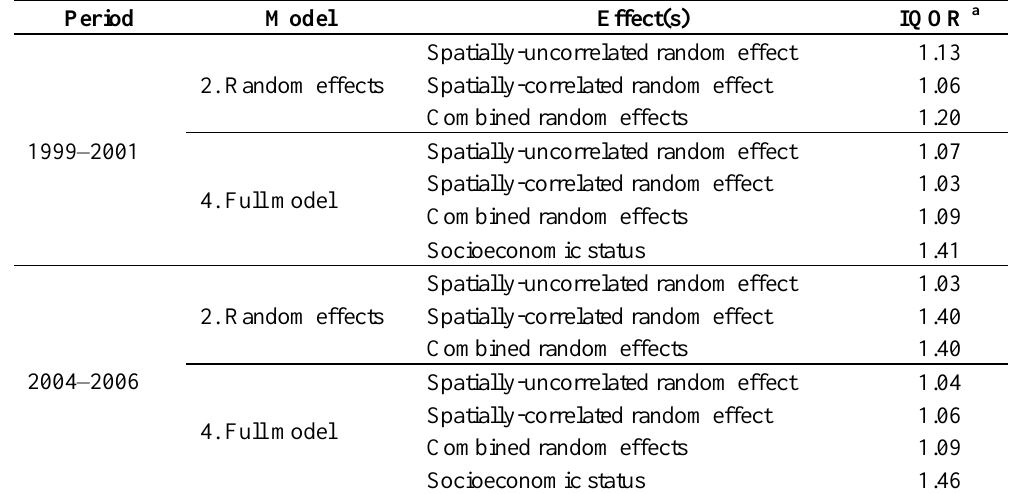
Table 1. Effect sizes for random effects and socioeconomic status, expressed as interquartile odds ratios among suburbs in poor fetal